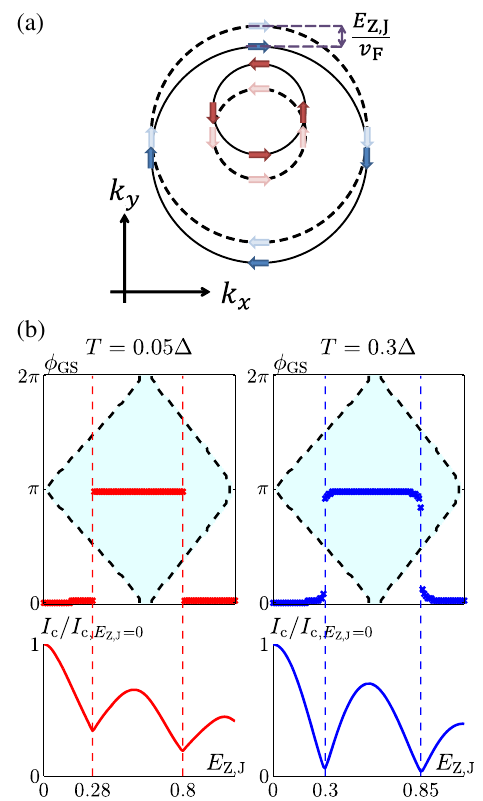
FIG. 2. (a) A Zeeman field along x shifts the two Rashba-split Fermi surfaces of the 2DEG in opposite directions along y . The arrows indicate the orientation of the spin at each point on the Fermi surface. (b) The phase difference ϕ that minimizes GS the ground-state energy (upper panel) and the critical current modulation (lower panel) as a function of the Zeeman field obtained numerically using a tight-binding model for the system (see Appendix D 2 for details of the model). The parameters used 10 , t ¼ 1 , α ¼ 0 . 1 , μ ¼ − 2 . 4 , and are as follows: W ¼ 5 , W SC ¼ Δ ¼ 0 . 3 [31]. The left (right) panel corresponds to a temperature 1 throughout of T ¼ 0 . 05 Δ ( T ¼ 0 . 3 Δ ). (Note that we set k B ¼ the paper.) The light blue color indicates the region in the parameter space for which the system is in the topological phase. As the Zeeman field is varied, the system undergoes a series of first-order topological phase transitions, in which ϕ changes GS abruptly between values lying in the topological and trivial regions of the phase diagram. The critical current exhibits minima at the points of the phase transitions. As the temperature is increased, the minima become